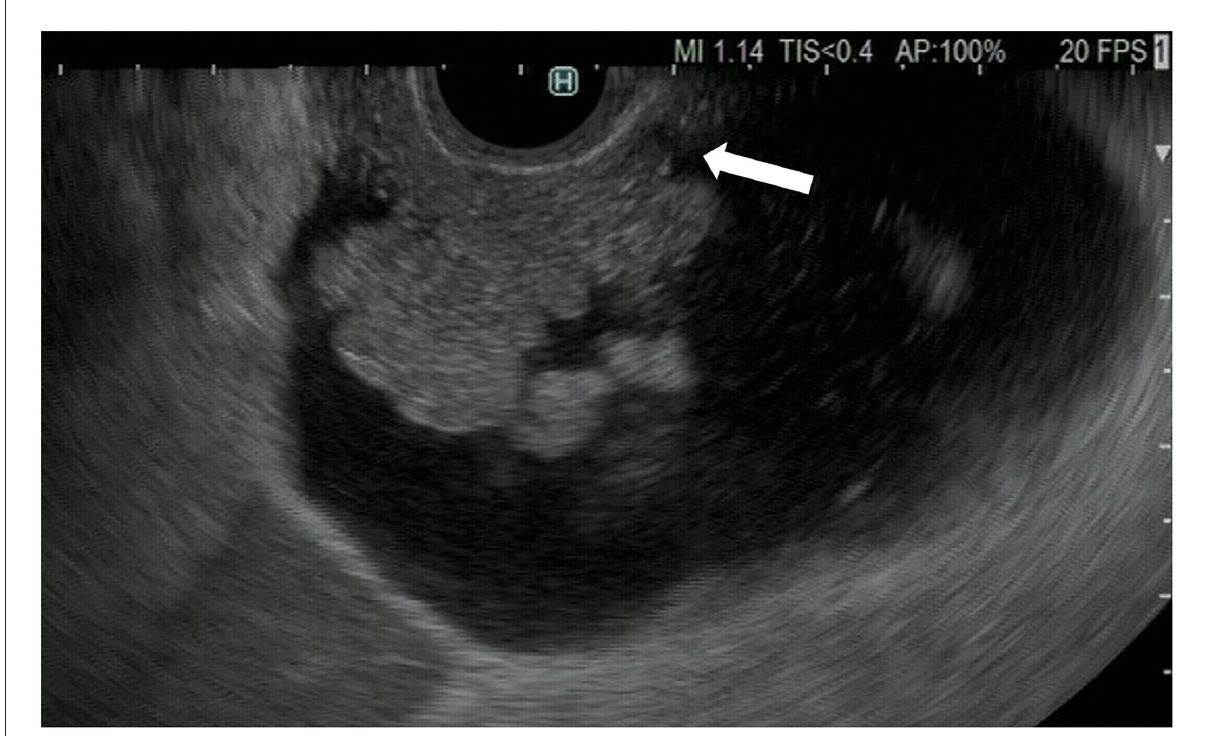
FIGURE2 Fundamental B-mode EUS for gallbladder polypoid lesions. Gallbladder adenocarcinoma: internal hypoechoic heterogenous papillary elevated mass lesion (arrow).